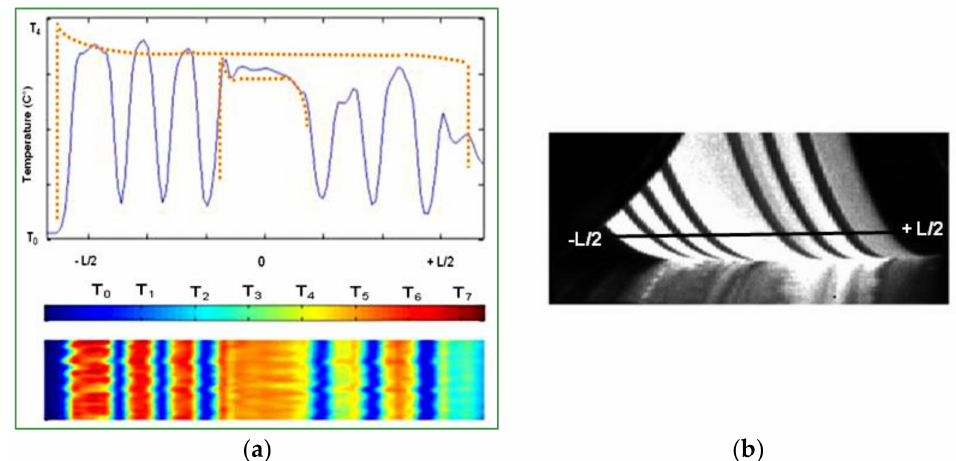
Figure 11. Experimental test: ( a ) thermal evolution of the tire tread rolling on a drum, ( b ) image of the contact